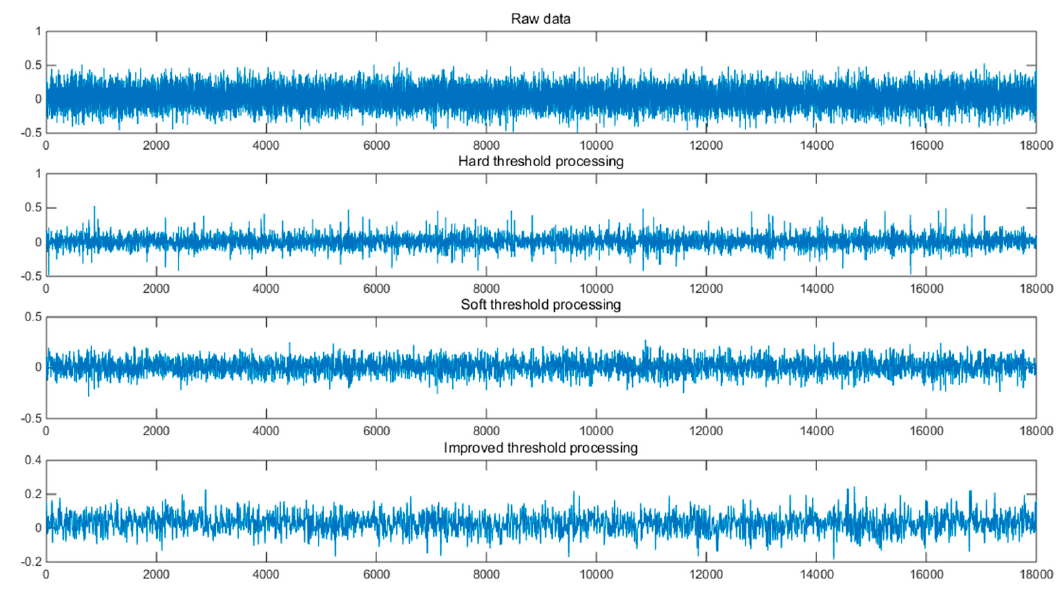
Figure 6. Contrast of denoised data and original data.